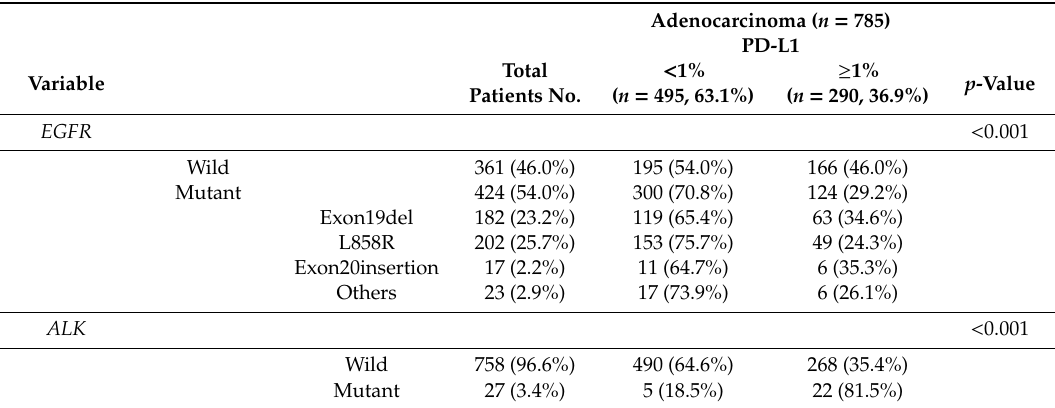
Table A3. Association between PD-L1 expression and driver genetic status in lung adenocarcinoma (1% cuto ff